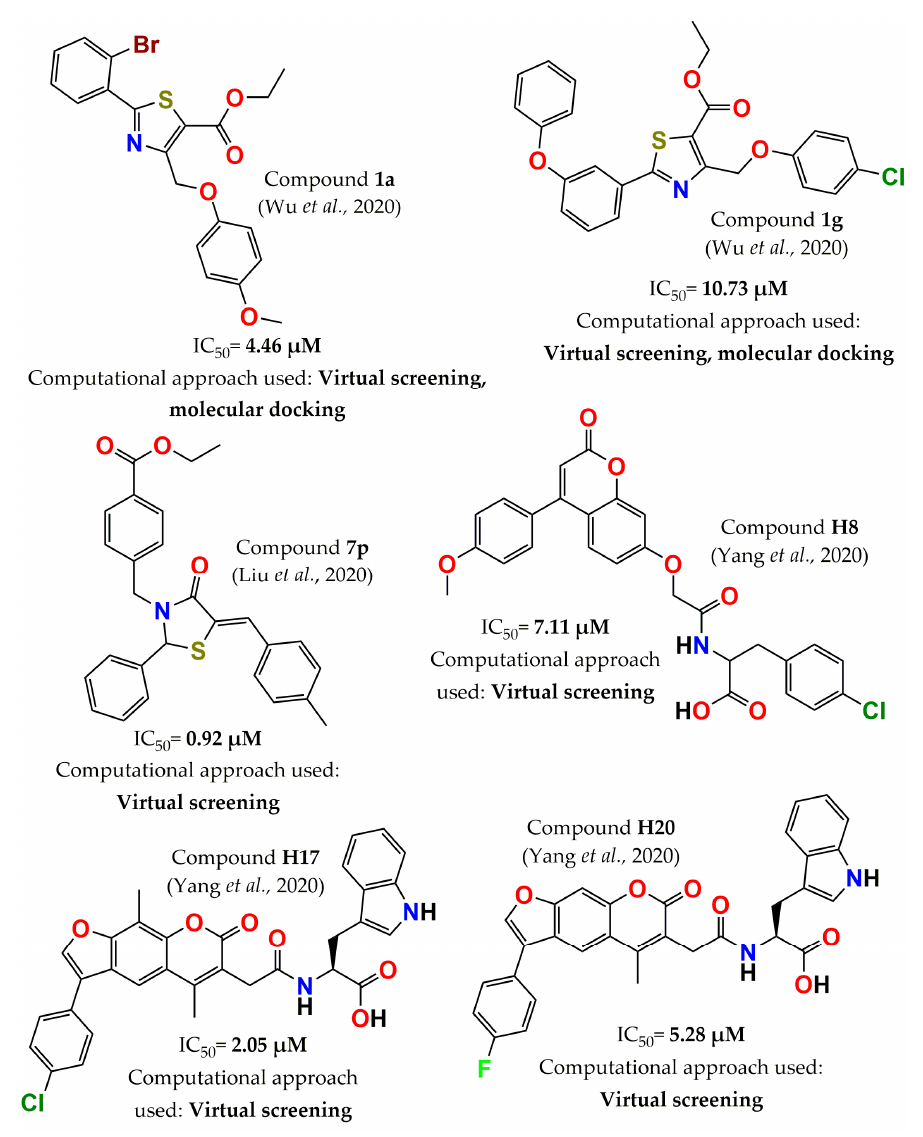
Figure 10. Structure of the most potent PTP1B inhibitors reported in 2020 discovered through computational approaches.